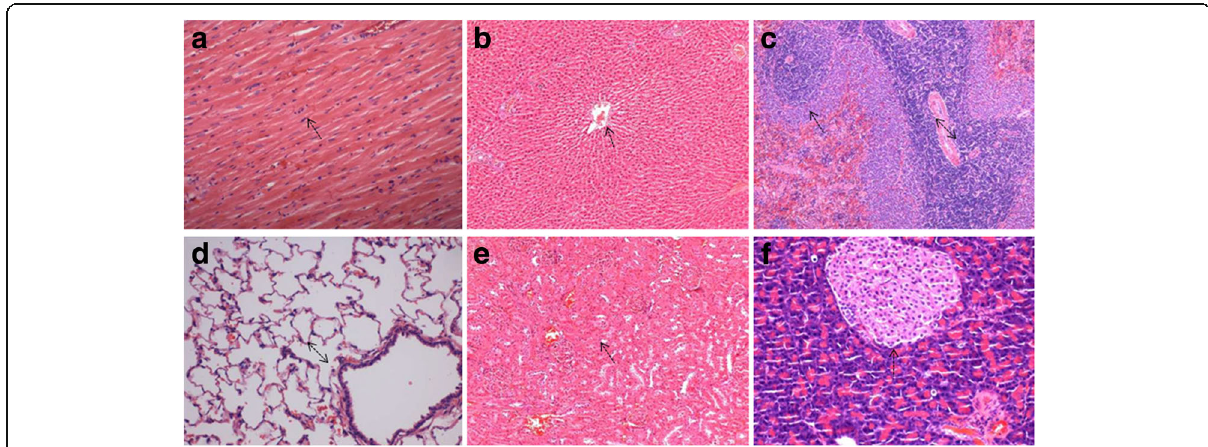
Fig. 10 Histopathological analysis of organs stained with H&E. Histopathology showing normal morphology from rats treated with Jueyin granules at the dose of 7.5 g/kg/day. a heart, b liver, c spleen, d lung, e kidney, f pancreas; scale bar = 100 μ m